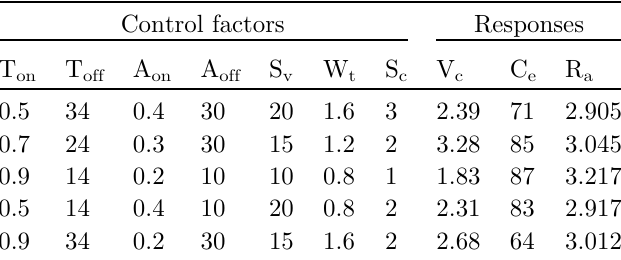
Table 6. Veri fi cation experiments for mathematical model.